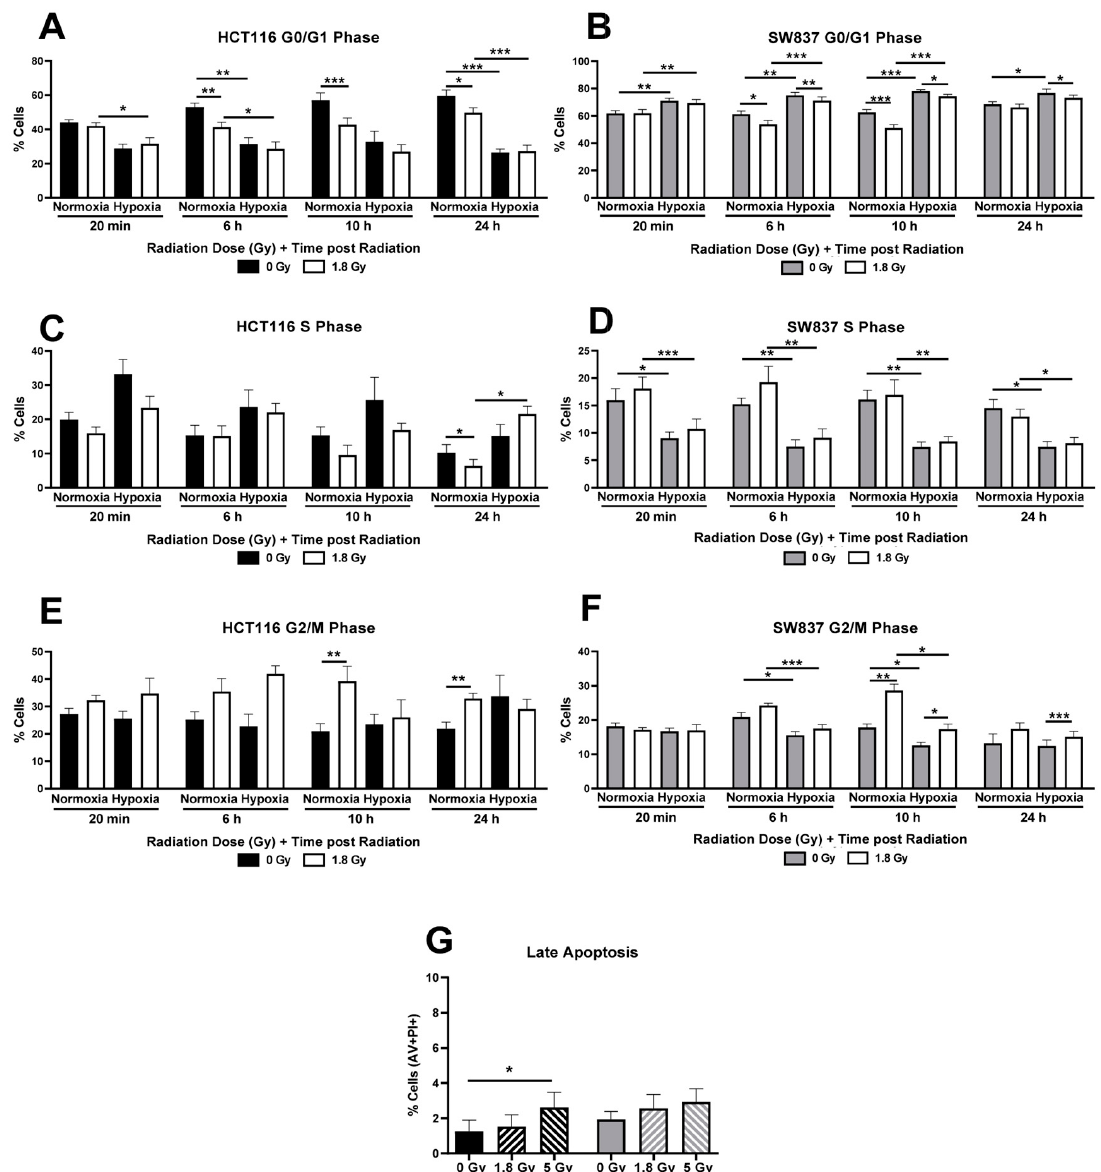
controls (Figure 3A,B).